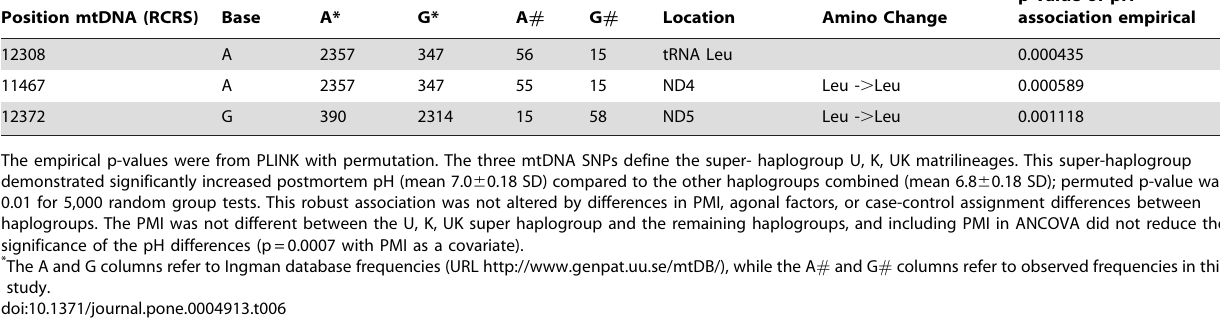
Position mtDNA (RCRS) Base